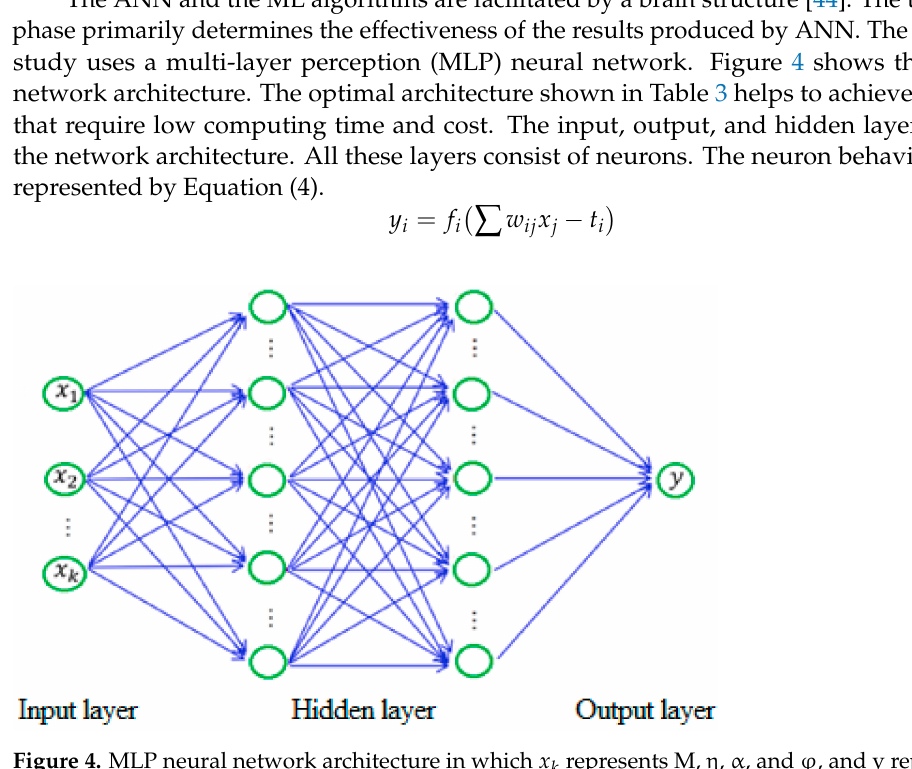
Figure 4. MLP neural network architecture in which x k represents M, η , α , and ϕ , and y represents the output base pressure ( β